Question: Write a single sentence explaining what this figure depicts.
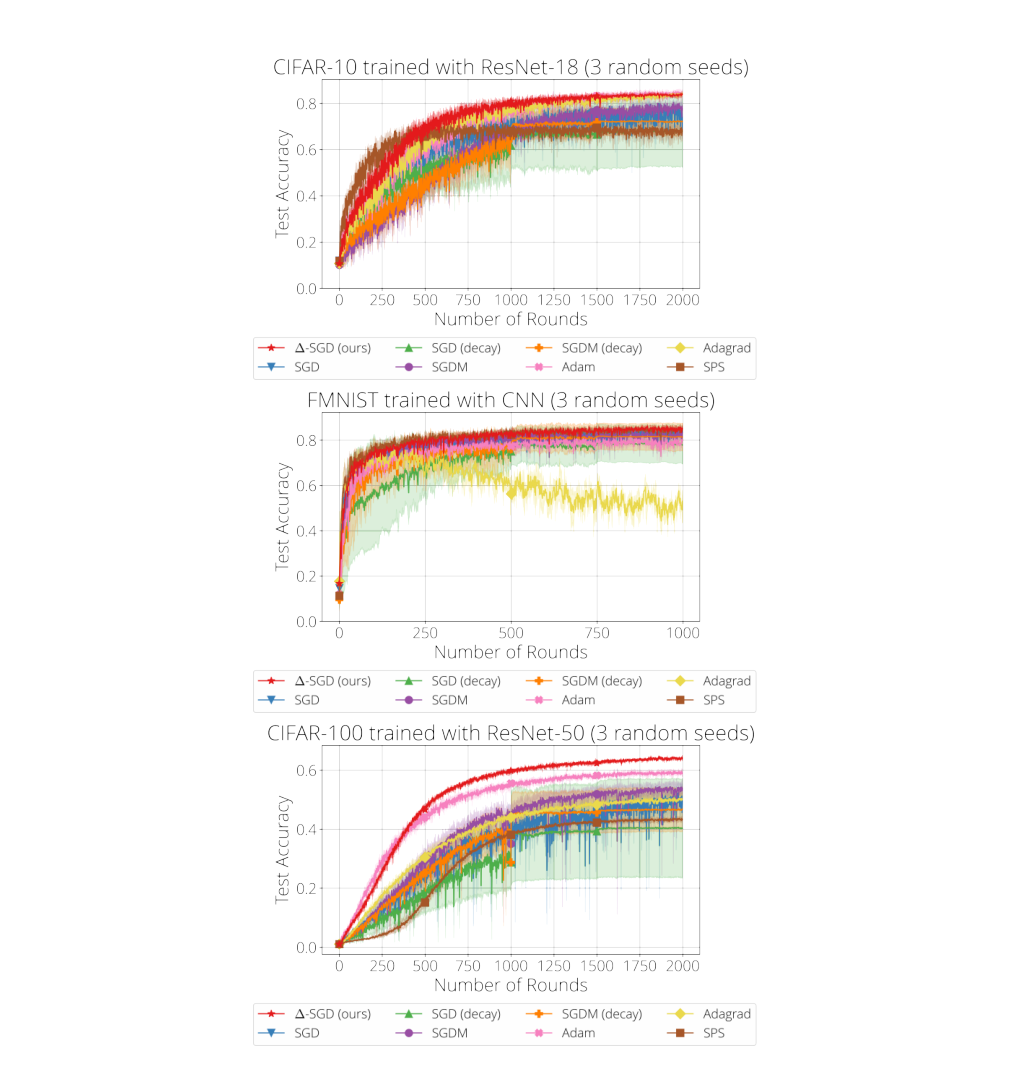
Answer: Additional plots for CIRAR-10 classification trained with a ResNet-18, FMNIST classifica- tion trained with a CNN, and CIFAR-100 classification trained with a ResNet-50, repeated for three independent trials. The average is plotted, with shaded area indicating the standard deviation.